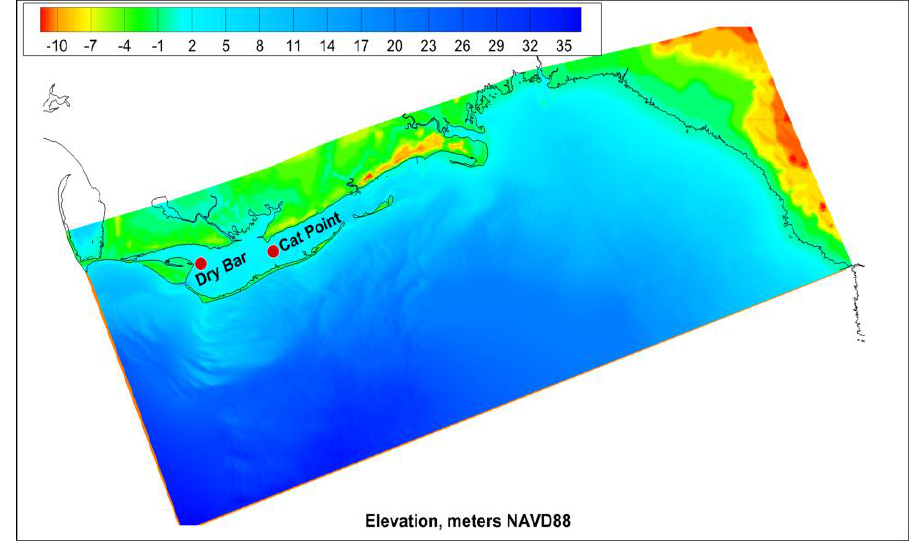
Figure 2. CH3D model grid bathymetry/topography, the orange lines at the south and west ends of the domain denote the model open boundary.